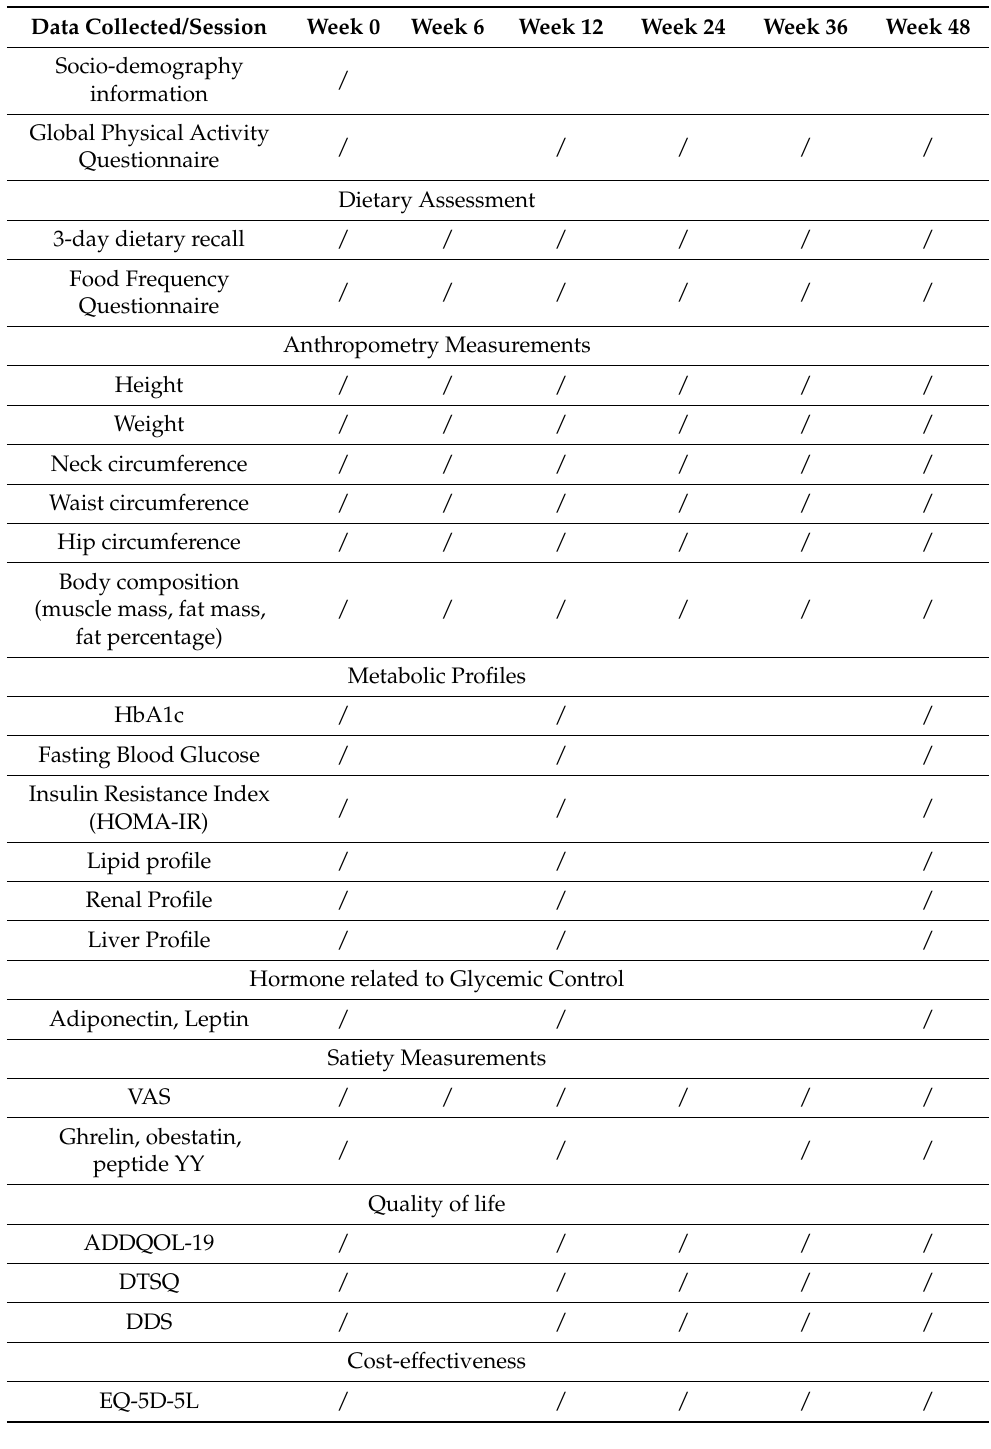
Table 3. Data collection